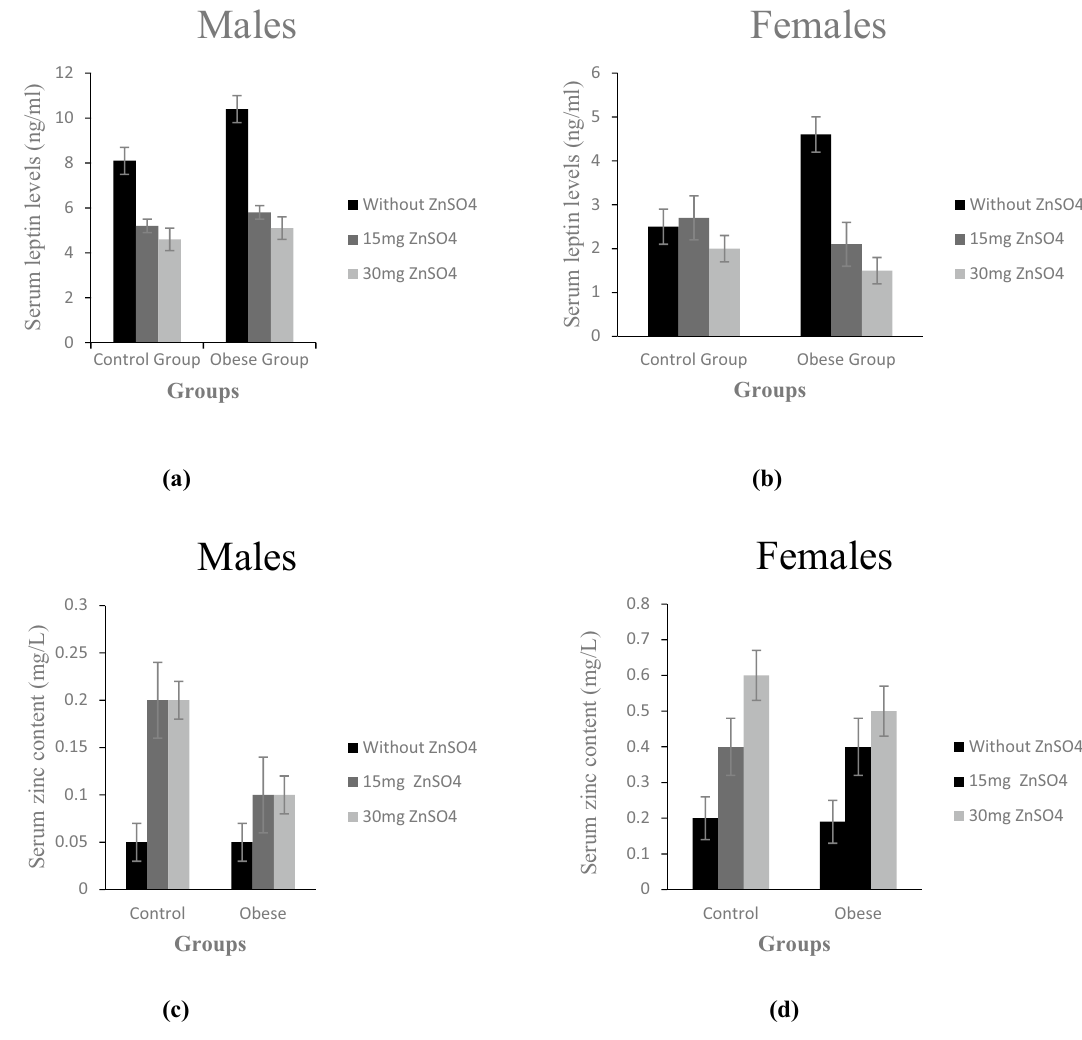
Figure 1. ( a , b ) Serum levels of leptin (ng/ml) in control and obese groups; without ZnSO 4 , 15 mg ZnSO 4 , and 30 mg ZnSO 4 ; in male rats and female rats, respectively; ( c , d ) zinc content in control and obese groups; without ZnSO 4 , 15 mg ZnSO 4 , and 30 mg ZnSO 4 ; in male and female rats, respectively; Results are expressed as (mean ±